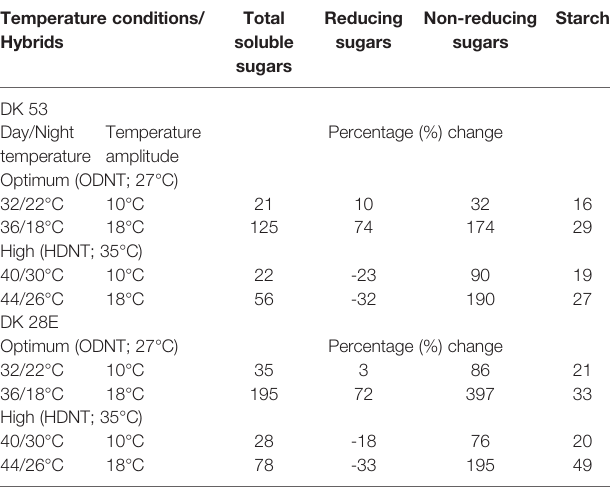
Values in each column are mean of percentage change of two